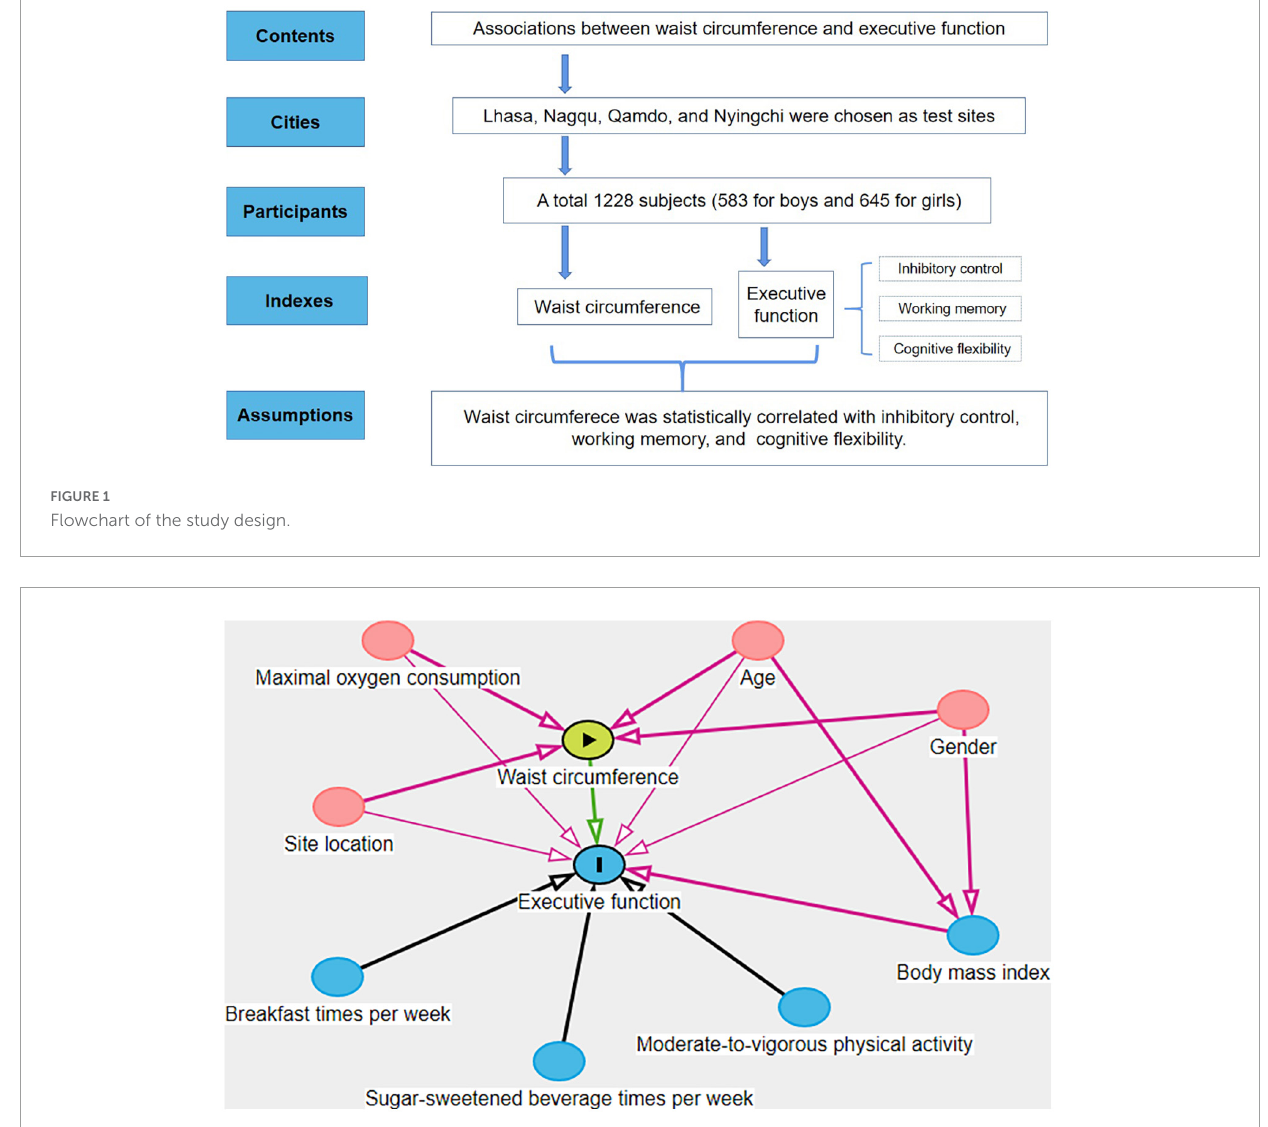
FIGURE2 Directed acyclic graph of the associations between waist circumference and executive